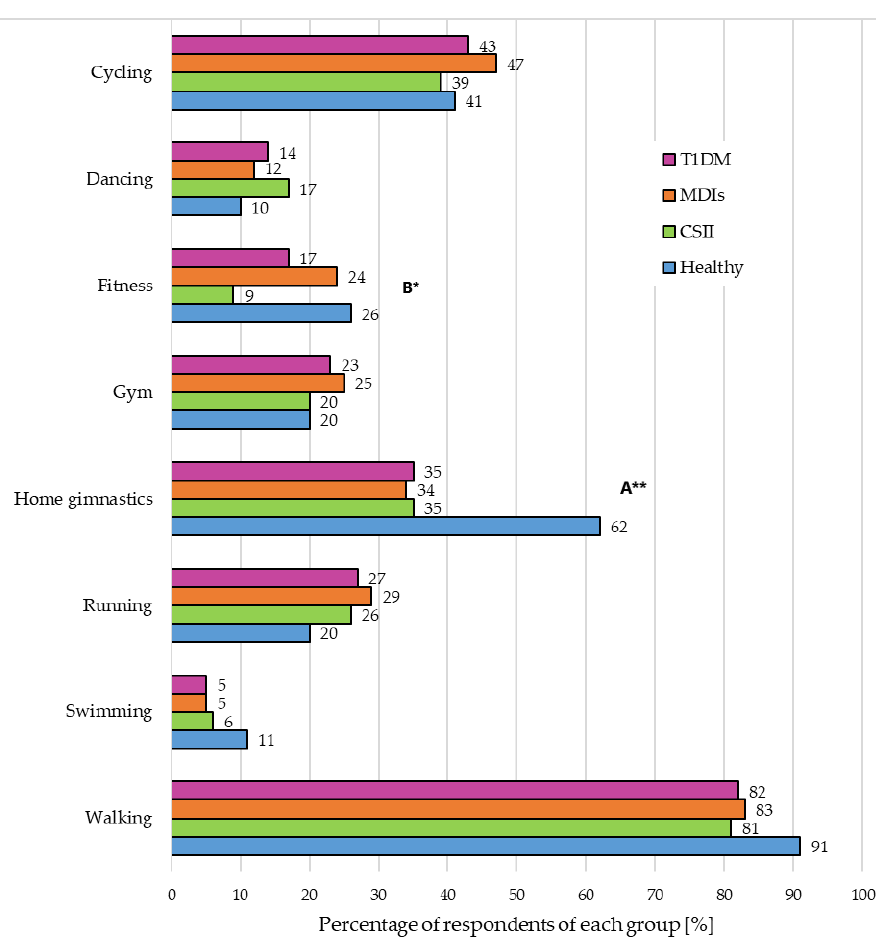
Figure 1. Type of physical activity chosen by study participants during the second wave of the COVID-19 pandemic. Abbreviations: continuous subcutaneous insulin infusion (CSII), multiple daily injections (MDIs), type 1 diabetes mellitus (T1DM). Statistically significant dependence between variables: A T1DM vs. Healthy, B CSI vs. MDIs (the Chi-square test), * p < 0.05 and ** p < 0.001.